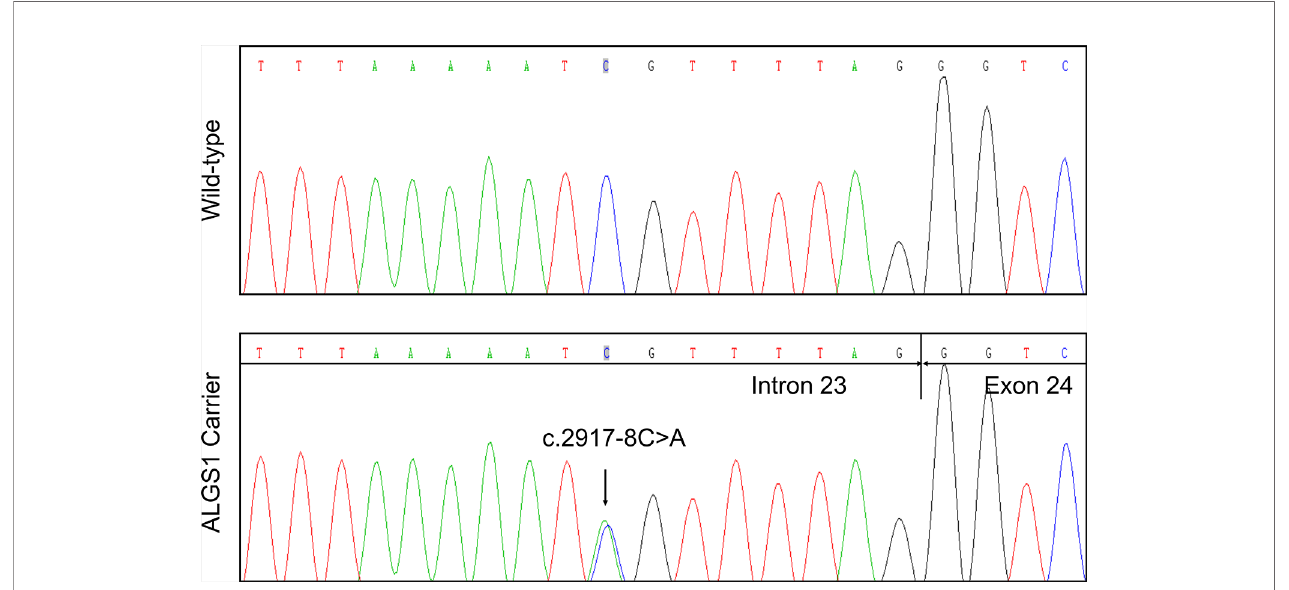
FIGURE 2 | Identi fi cation of a novel JAG1 pathogenic variant in the proband. Sanger sequencing veri fi ed the next generation sequencing (NGS) result. The arrows indicate the alteration from C to